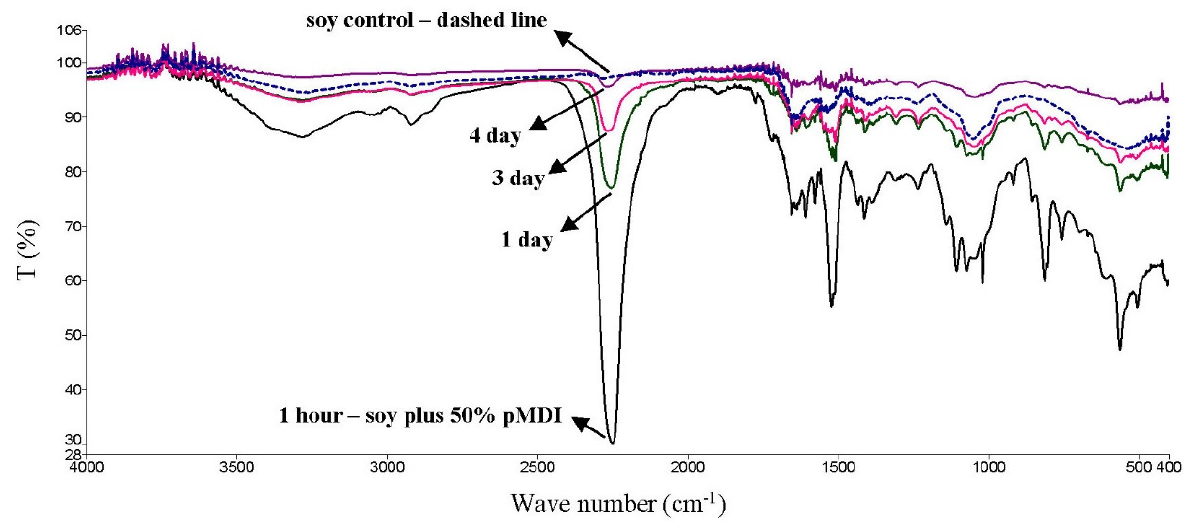
Figure 3. Soy flour reacted with 50% pMDI analyzed with FTIR after 1 h and 1, 3, and 4 days. The soy flour control with no pMDI is the dashed line.